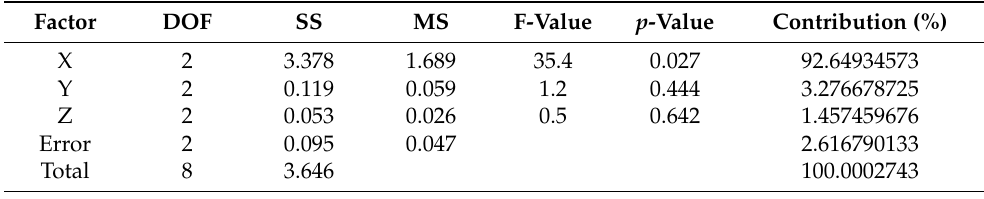
Figure 6. SN ratio graph for the LOC. Table 9. ANOVA for the LOC for the MHD approach.